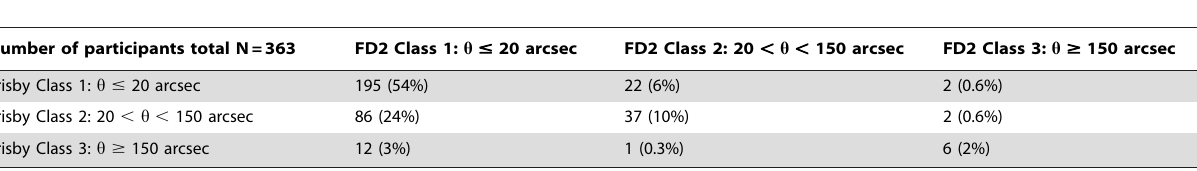
Table 6. Number of participants in the 3 classes of stereoacuity, as assessed on the Frisby (rows) and FD2 tests (columns) for 363 participants for whom both tests were